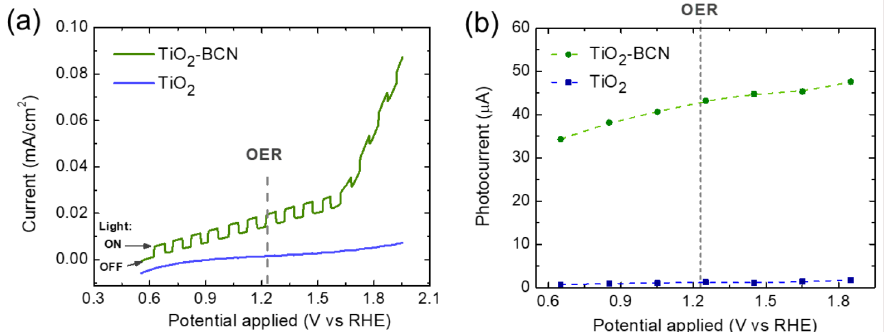
Figure 6. ( a ) Linear sweep voltammetry curves for bare TiO 2 and TiO 2 -BCN under intermittent illumination conditions. ( b ) Photocurrents obtained for different constant applied